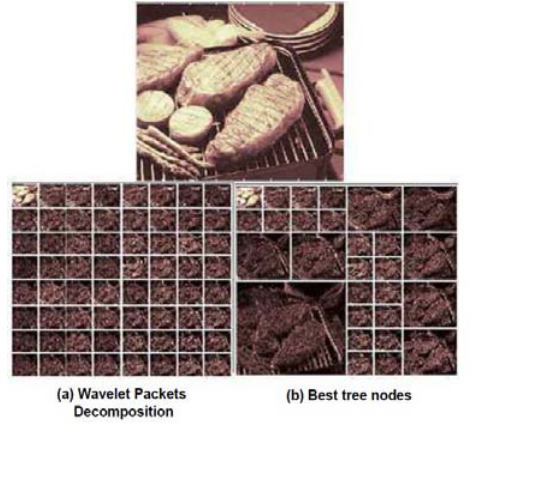
Fig. 4. Top image is the input Image and bottom images are the representation of corresponding full wavelet packets tree decomposition and nodes obtained from best tree of the wavelet packets